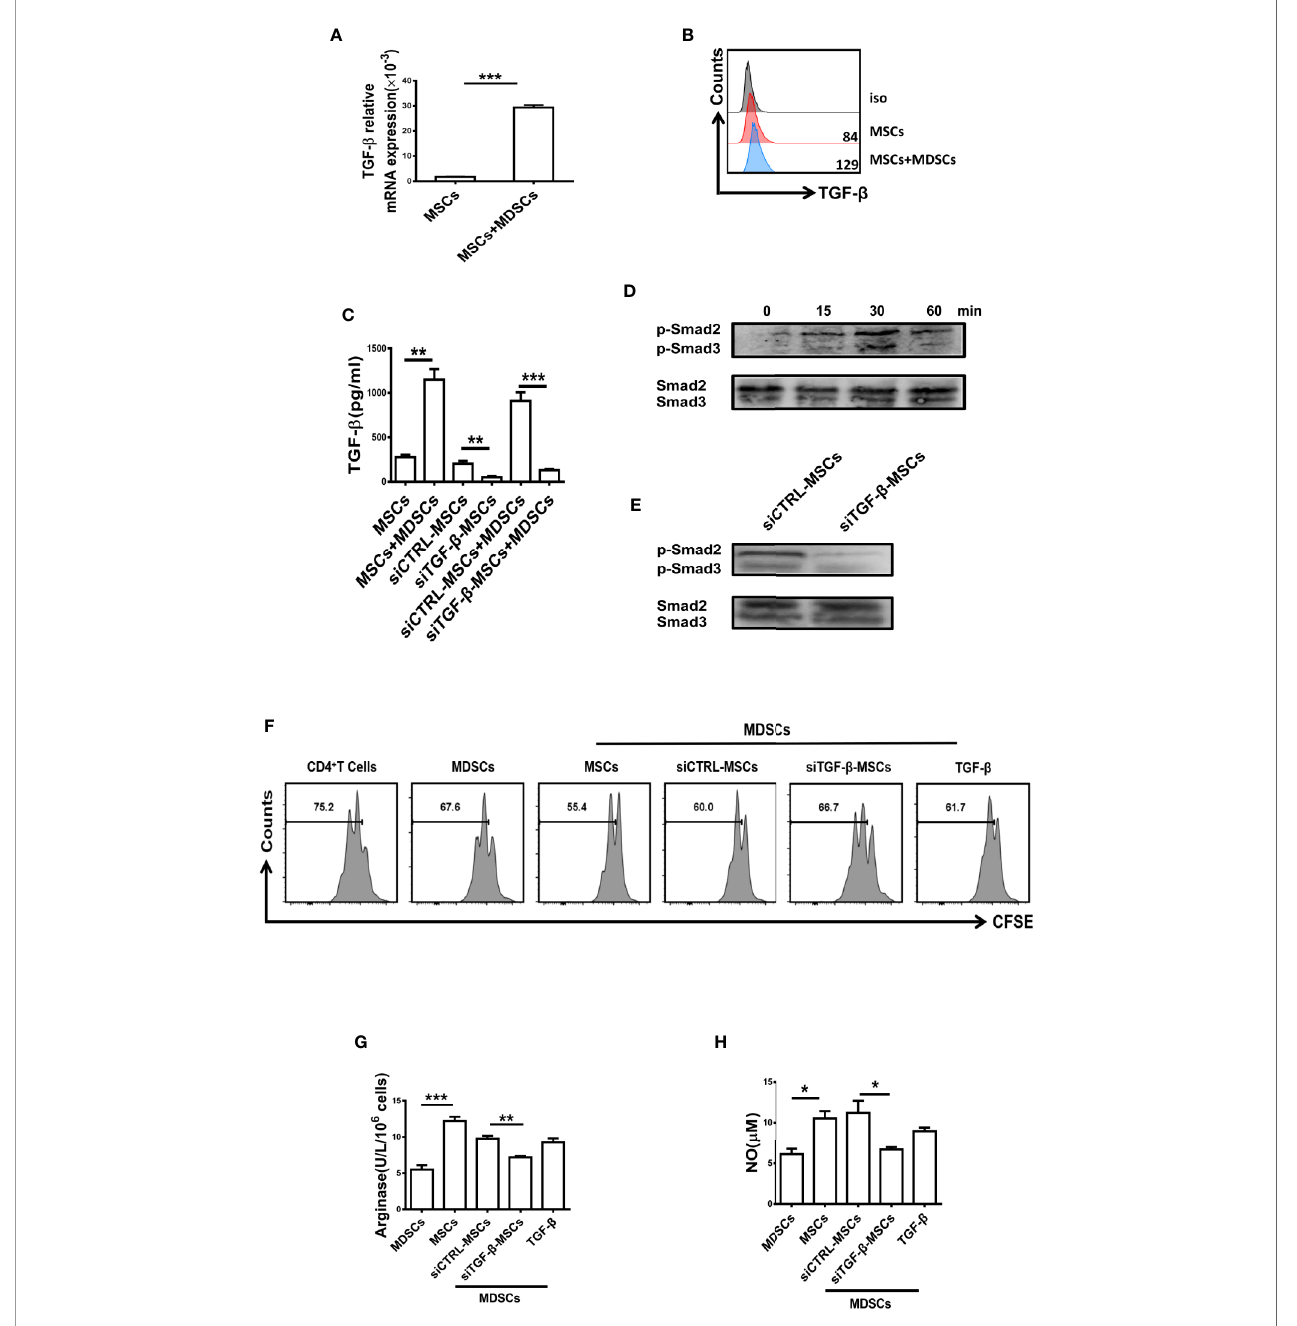
FIGURE 4 | The suppressive capacity of MDSCs was enhanced by BM-MSCs-secreted TGF- b . (A, B) The mRNA level (A) and protein level (B) of TGF- b in BM- MSCs co-cultured with MDSCs were analyzed by qRT-PCR and fl ow cytometry respectively. (C) The concentration of TGF- b in the conditioned medium of control MSCs and TGF- b silenced BM-MSCs with or without MDSCs were measured by ELISA. (D, E) The expression of phosphorylated Smad2/3 in MDSCs co-cultured with MSCs or TGF- b -silenced MSCs was determined by western blot. (F) TGF- b -silenced MSCs were co-cultured with MDSCs for 48 h, then MDSCs were collected to co-culture with CD4 + T cells in the presence of anti-CD3 and anti-CD28 mAbs for 72 h (MDSC:T cell ratio 1:1). CD4 + T cell proliferation was evaluated by staining with CFSE. Recombinant mouse TGF- b (0.8ng/ml) was used as a control. (G, H) The activity of arginase activity and the level of NO were detected in each group. The Data are shown as mean ± SD from three independent experiments. ***p < 0.001, **p < 0.01, *p < 0.05. NS, no signi fi